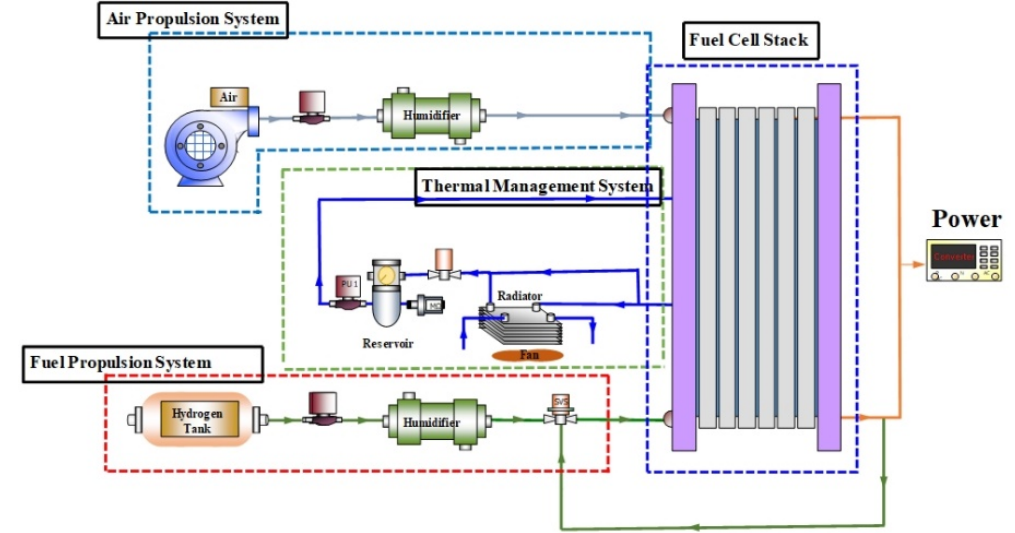
Figure 1. Schematic diagram of whole fuel cell system.